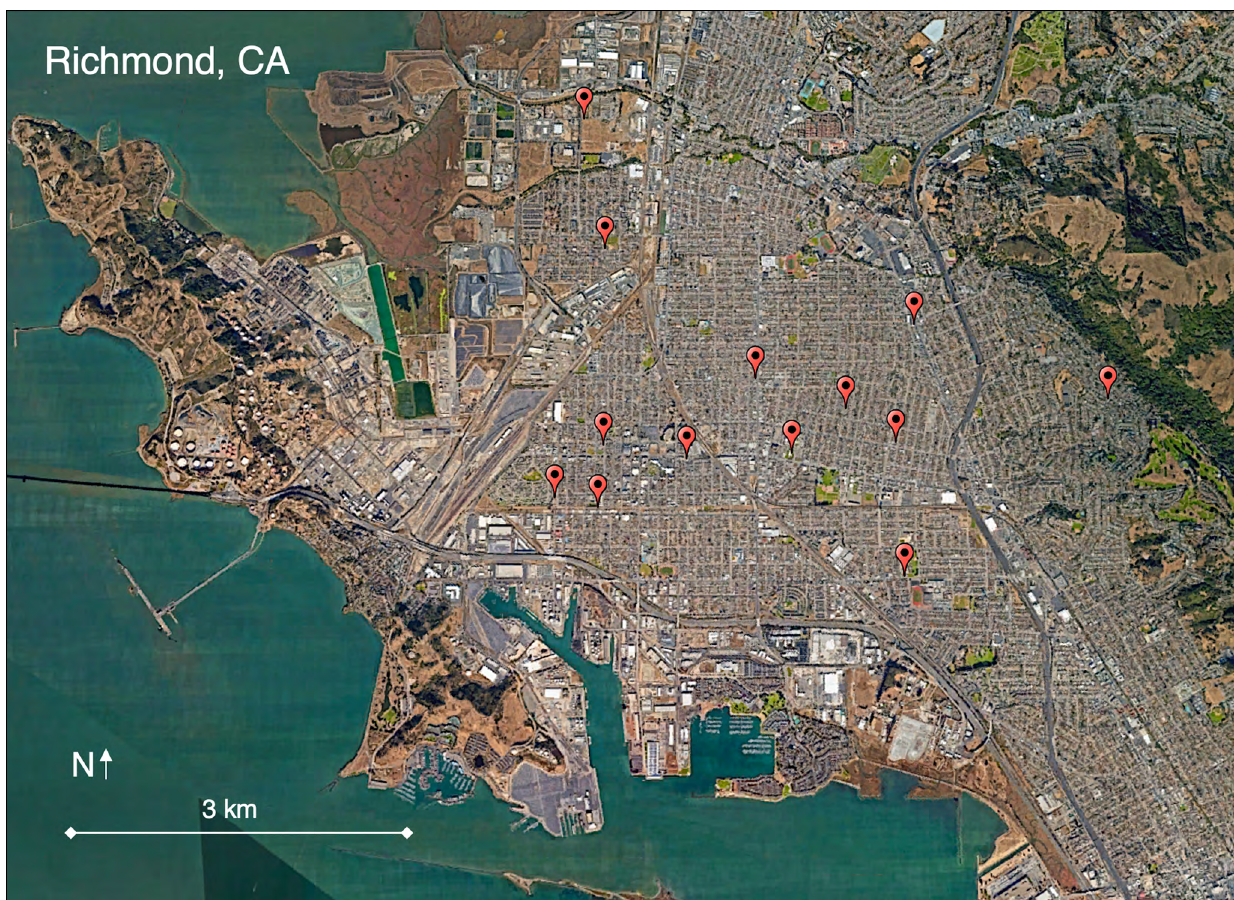
Figure 2 Locations of Tiny Free Seed Libraries (TFSLs) established by Richmond Grows Seed Lending Library (RGSLL) in Richmond, CA in response to the COVID-19 crisis,